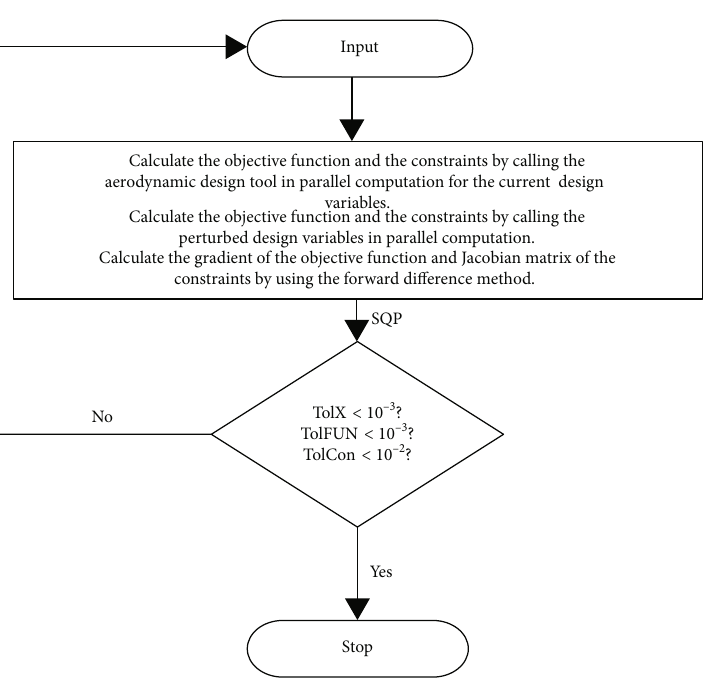
Figure 10: The fl owchart of the optimization process. Table 2: Geometric properties of the baseline UAV ’ s wing.